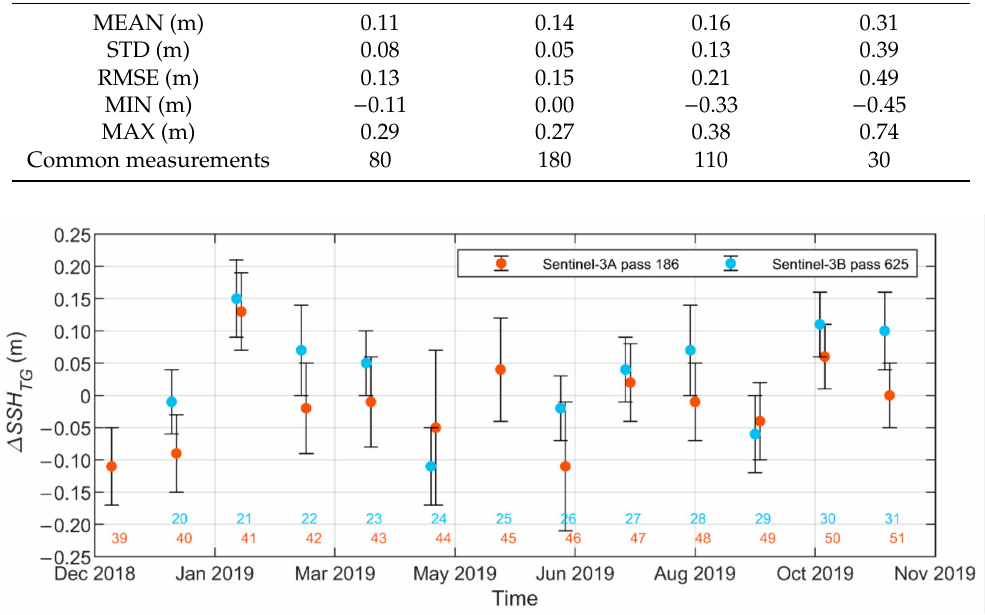
Figure 7. Residual di ff erences ( ∆ SSH TG ) between the sea surface height of Sentinel-3 ( SSH SA ) and the geoid-based sea surface height ( SSH TG ) in the Gulf of Finland. The zero line denotes the reference SSH TG . Coloured numbers indicate the corresponding cycle number for each satellite. Vertical bars represent the ± 1 σ standard deviations.